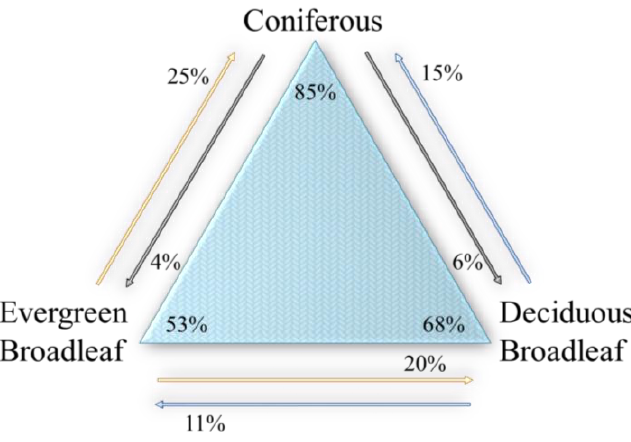
Figure 15. Triangular relationship of the forest classes and their accuracy and